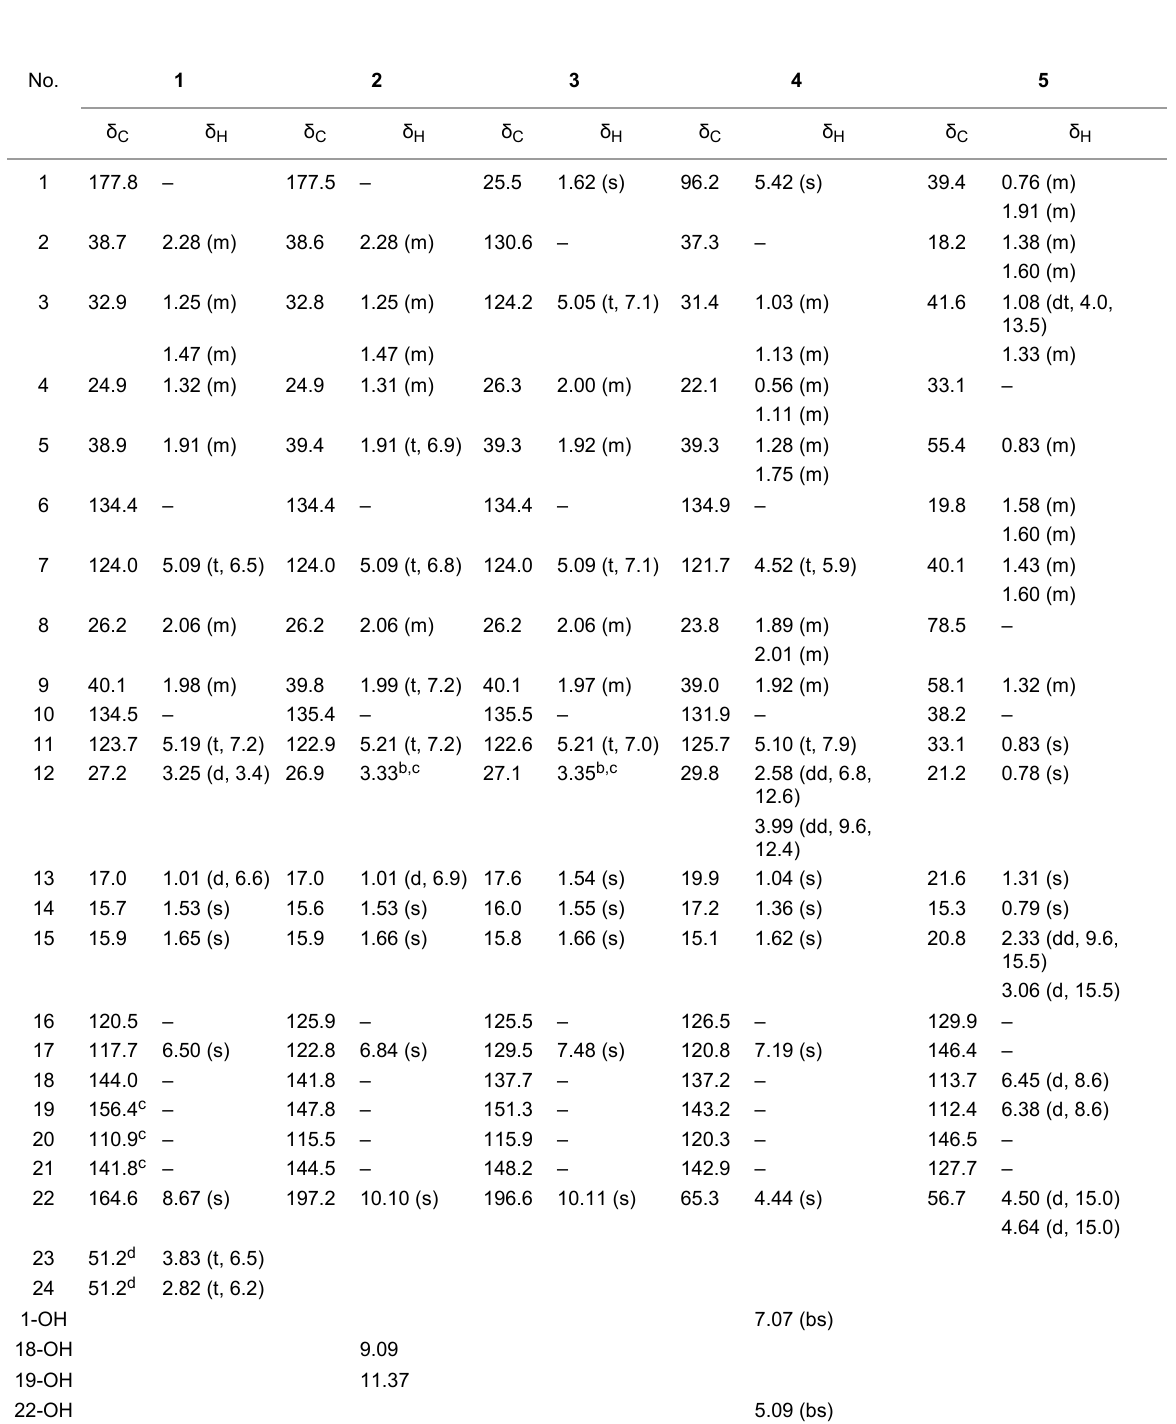
Table 1: NMR data of compounds 1 – 5 ( δ C 150 MHz, δ H 600 MHz in DMSO- d 6 ).